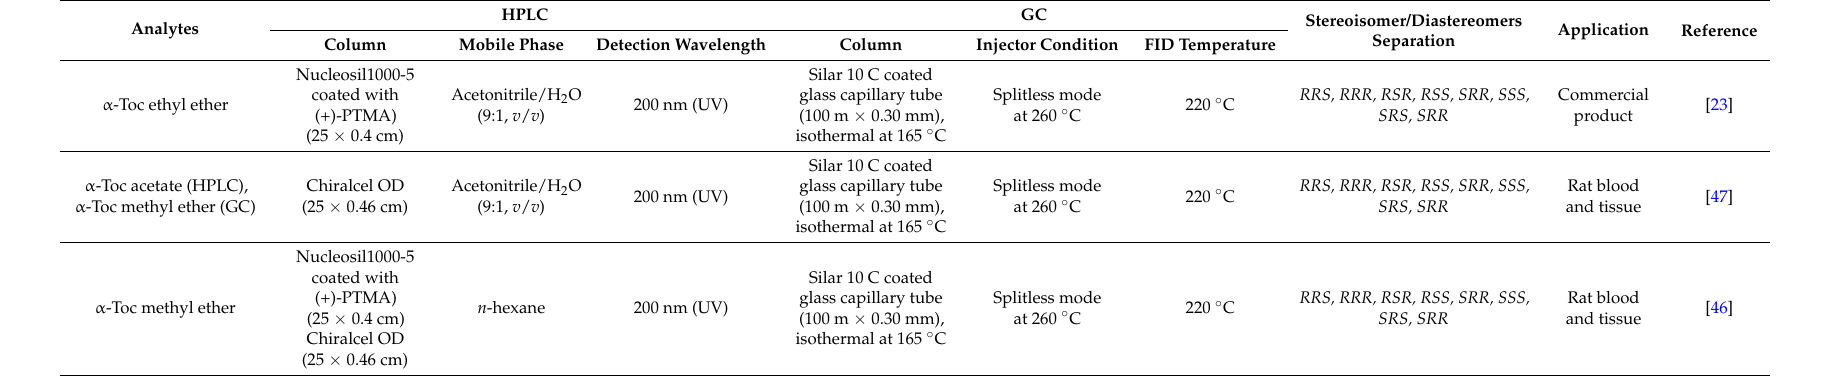
Table 3. Combination methods (HPLC-GC) for α -Toc